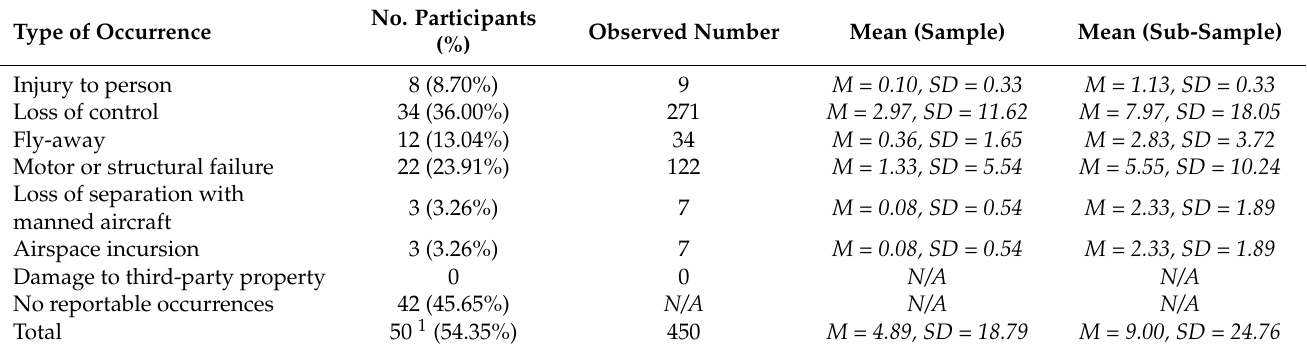
Table 2. Types of occurrences observed among